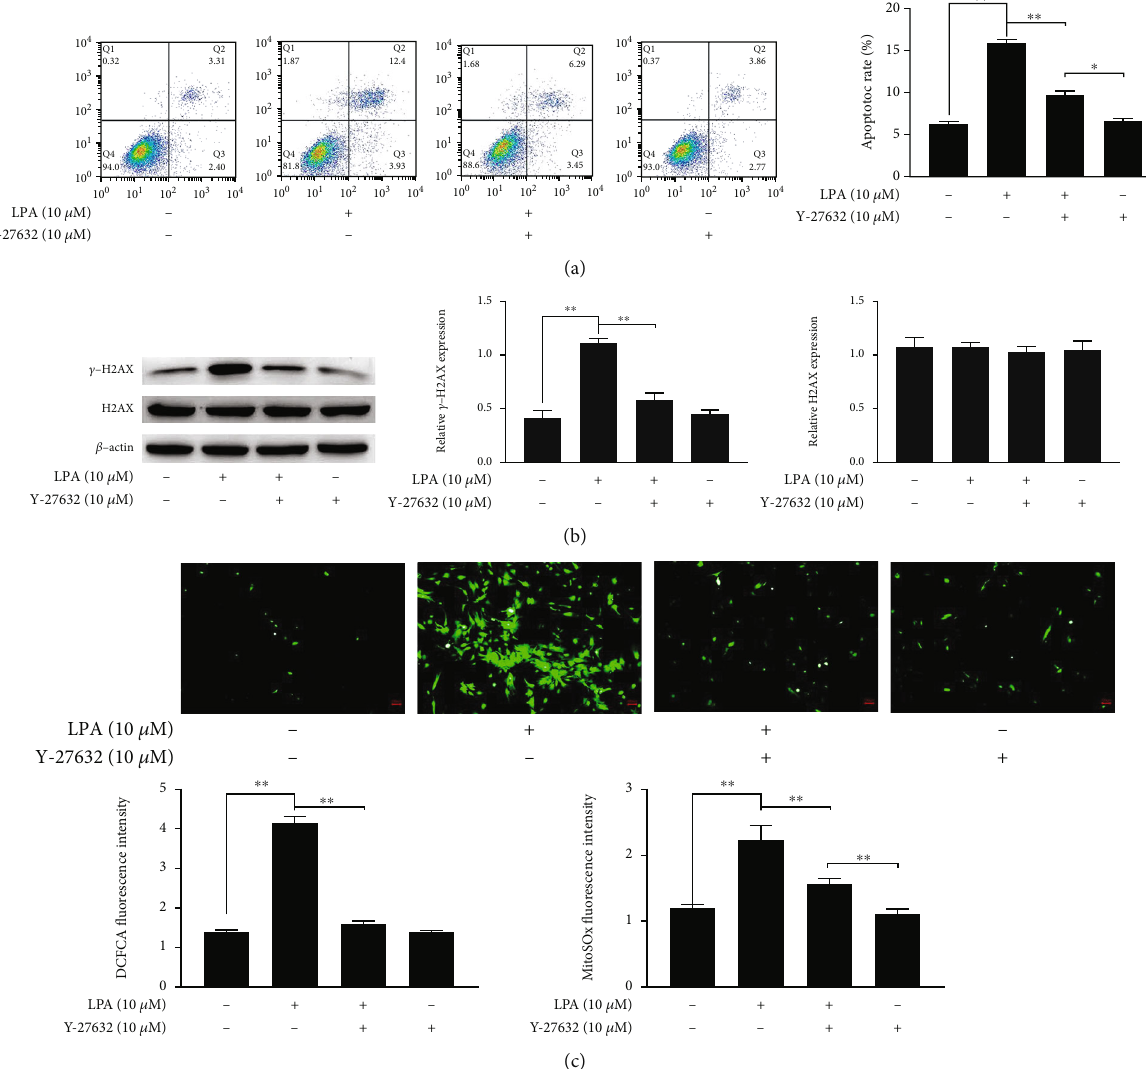
Figure 4: Rho kinase inhibitor alleviated apoptosis, DNA damage, and oxidative stress in the LPA-induced spinal cord neurons. (a) The apoptotic ratio was detected by fl ow cytometry. (b) The expression of DNA damage-related proteins in spinal cord neurons were measured by western blotting. (c) Quantity analysis of intensity of the DCFDA staining and MitoSOx staining. Asterisks indicate statistical signi fi cance ( ∗ p < 0 : 05 , ∗∗ p < 0 : 01